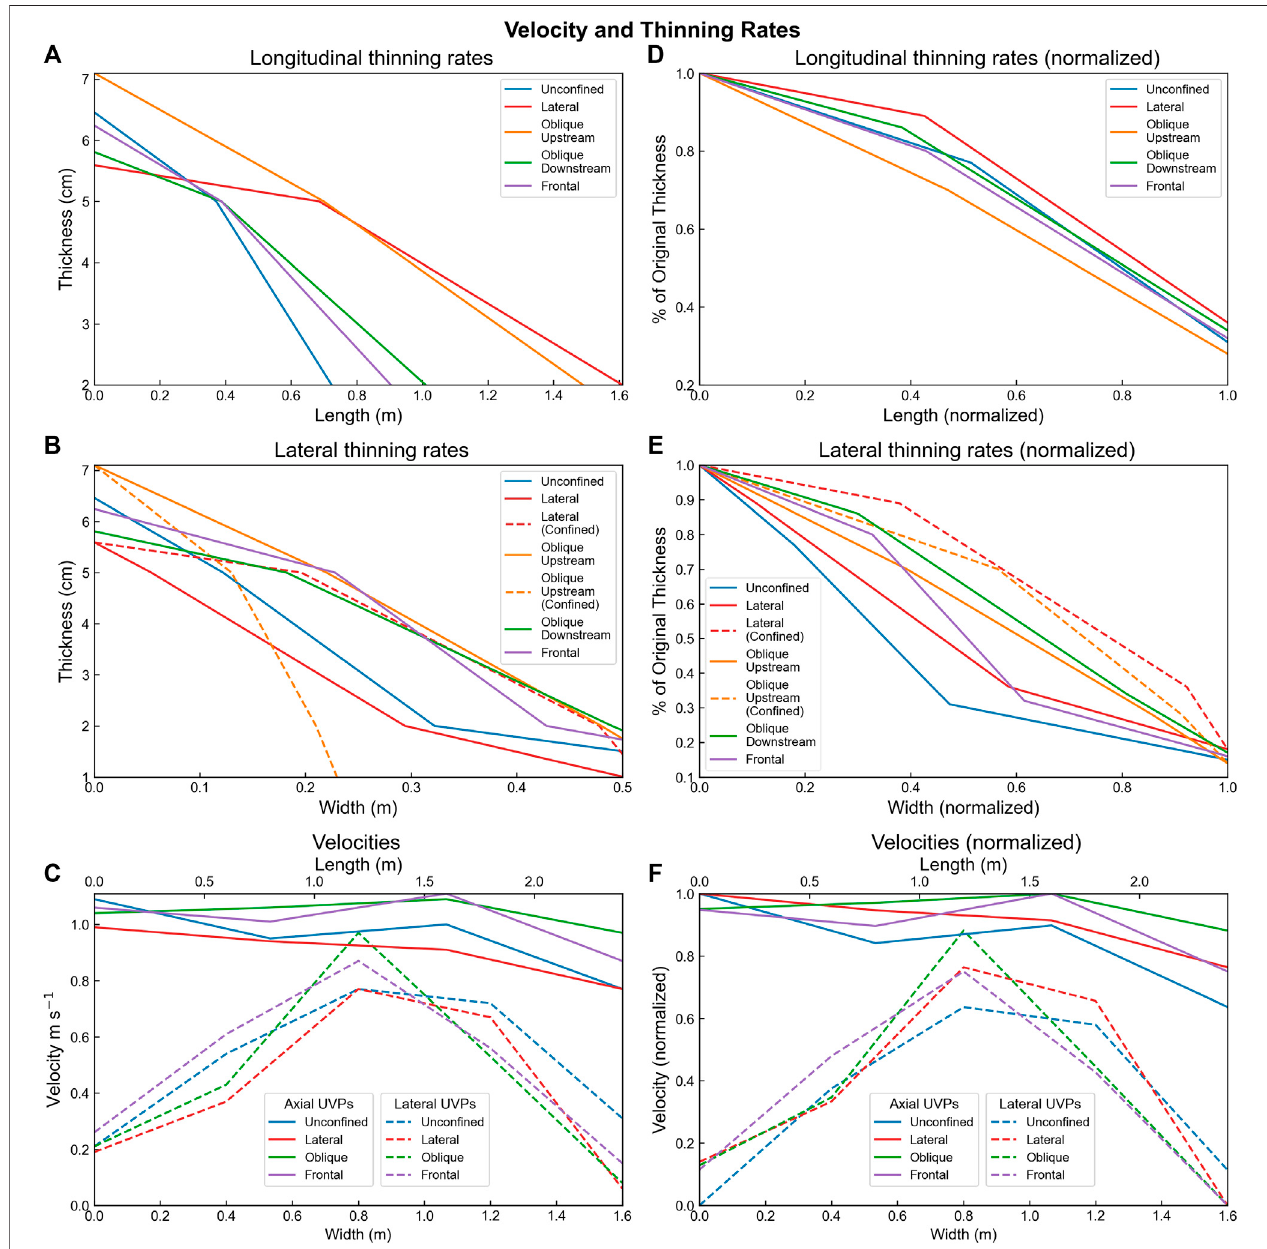
FIGURE 9 | Actual (A – C) and normalized (D – F) thinning and velocity rates recorded by these experiments. The deposits have been divided into their depositional components, i.e., in the oblique experiment the upstream con fi ned deposit is treated as a separate to the downstream uncon fi ned deposit.